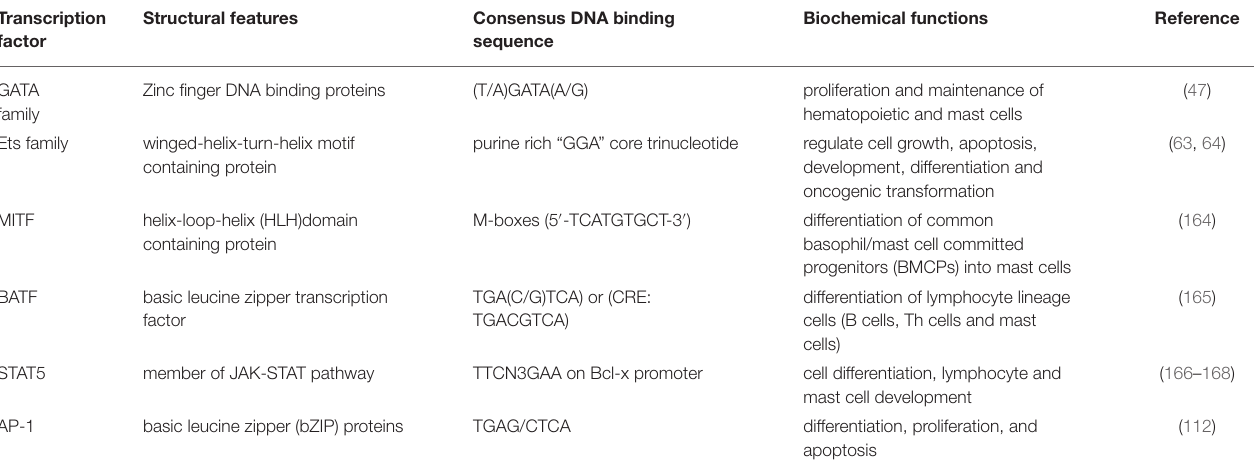
TABLE 2 | Structural features and biochemical functions of transcription